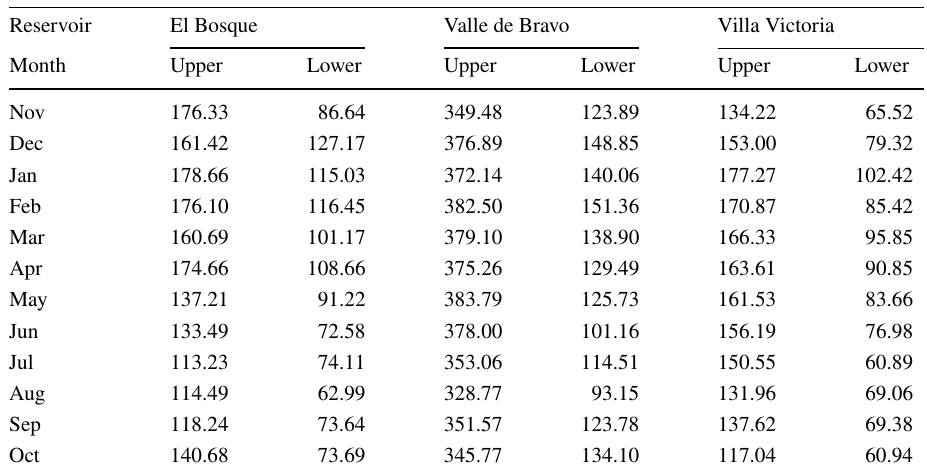
Fig. 6 The upper limit guide curve (UGC) and lower limit guide curve (LGC) obtained for each reservoir with genetic algorithm GA2 versus the corresponding curves based on empirically determined histori‑ cal operation patterns